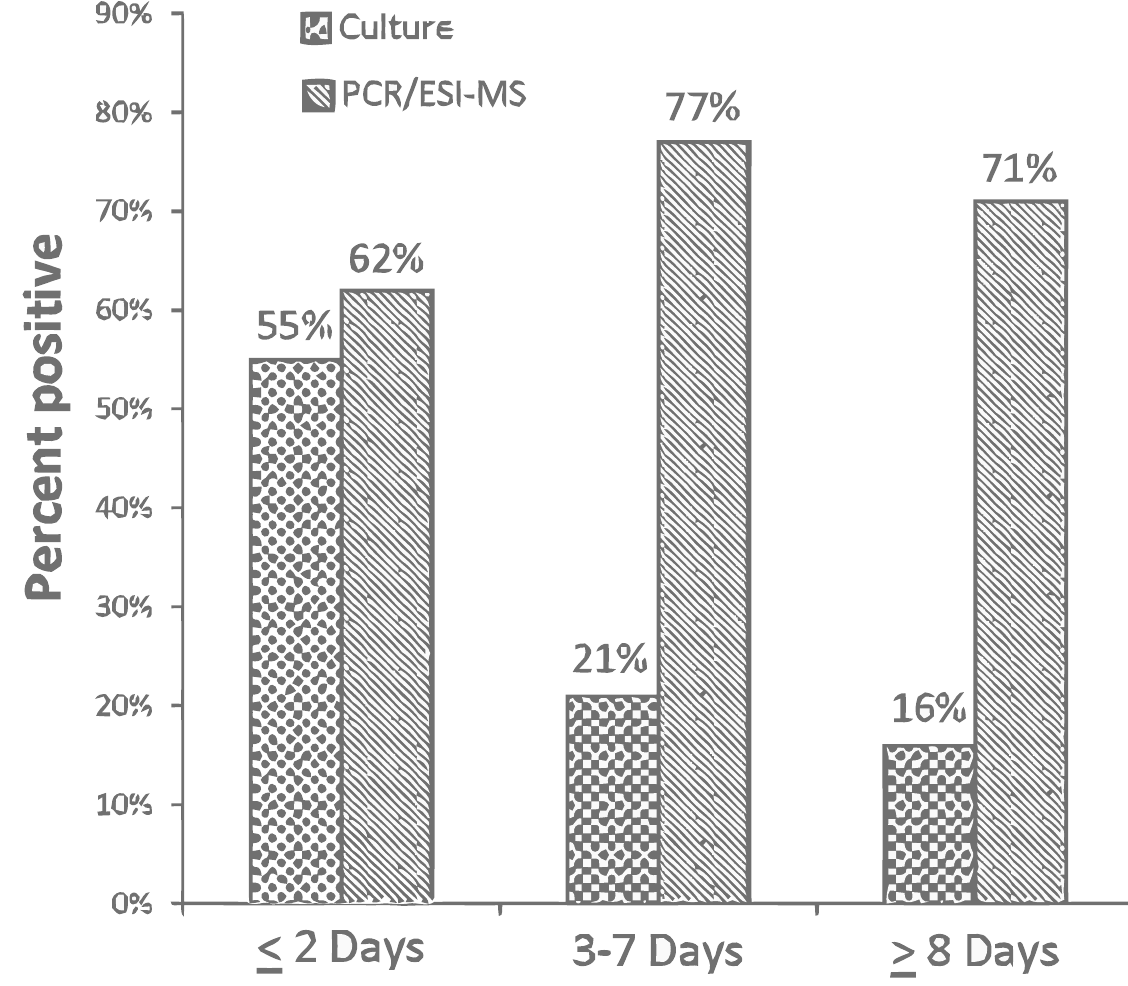
Fig 1. Culture vs. PCR/ESI-MS stratified by days of antibiotic treatment. Percent of a positive tests by culture vs. PCR/ ESI-MS stratified by days of antibiotictreatment.